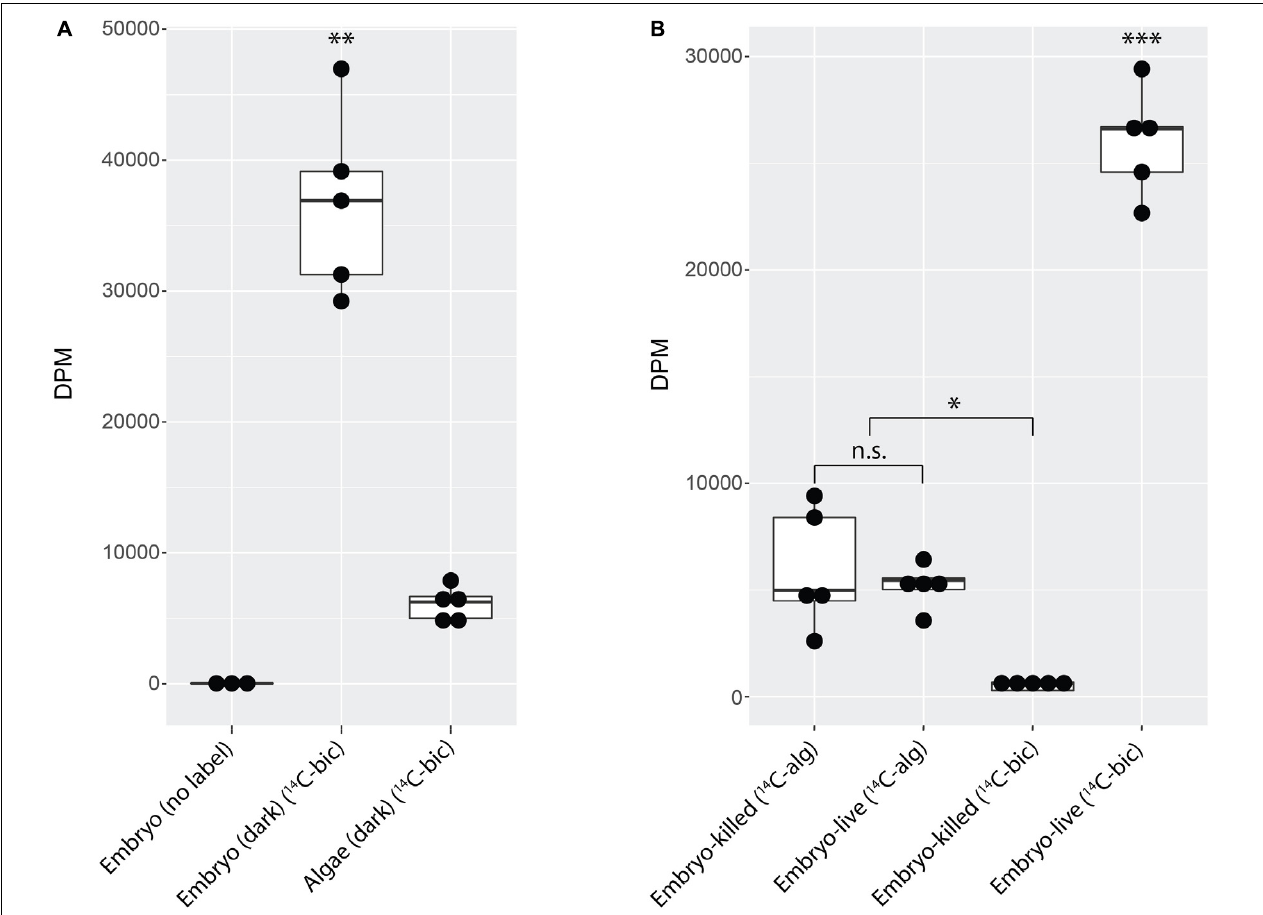
FIGURE 2 | A. maculatum embryos fix carbon. Box and whisker plots showing raw data (dark circles) range (thin lines) averages (thick horizontal lines) and upper and lower quartiles (box). In each plot, the y -axis represents radioactivity assayed per sample (DPM, disintegrations per minute); the x -axis represents the treatments: (A) embryo or algae incubated in the dark without (no label) or with 14 C-bicarbonate ( 14 C-bic). (B) Glutaraldehyde-killed or live embryo (embryo-killed and embryo-live, respectively) incubated in the light with 14 C-labeled alga ( 14 C-alg) or with 14 C-bicarbonate. n.s. = not significant, ∗ p < 0.05, ∗∗ p < 0.01, ∗∗∗ p < 0.001. Significance levels were determined by ANOVA followed by the Games-Howell post-hoc